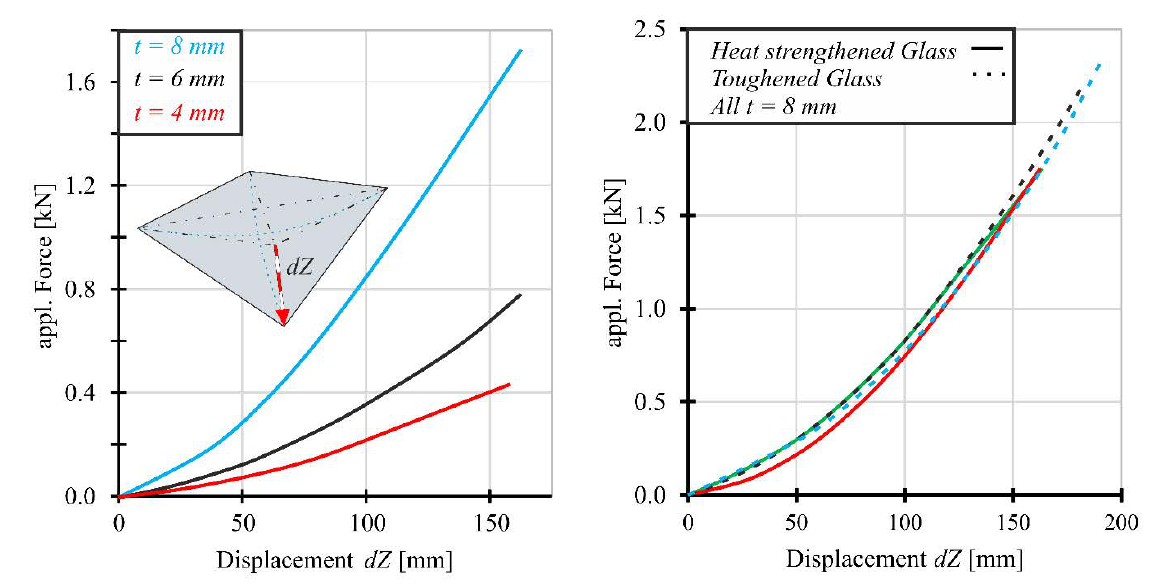
Fig. 3 Load-deflection Diagrams: (left) Comparison of different thicknesses and (right) different residual stress levels. The maximal deflection therefore depends on the thickness and the residual stress state of the investigated